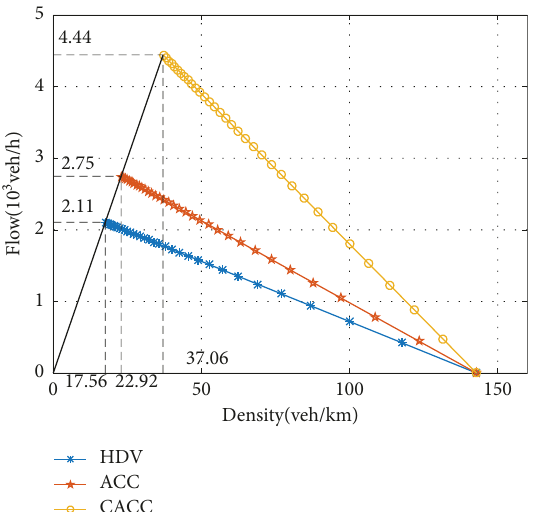
Figure 3: Fundamental diagram of homogeneous traffic flow under different vehicle types.